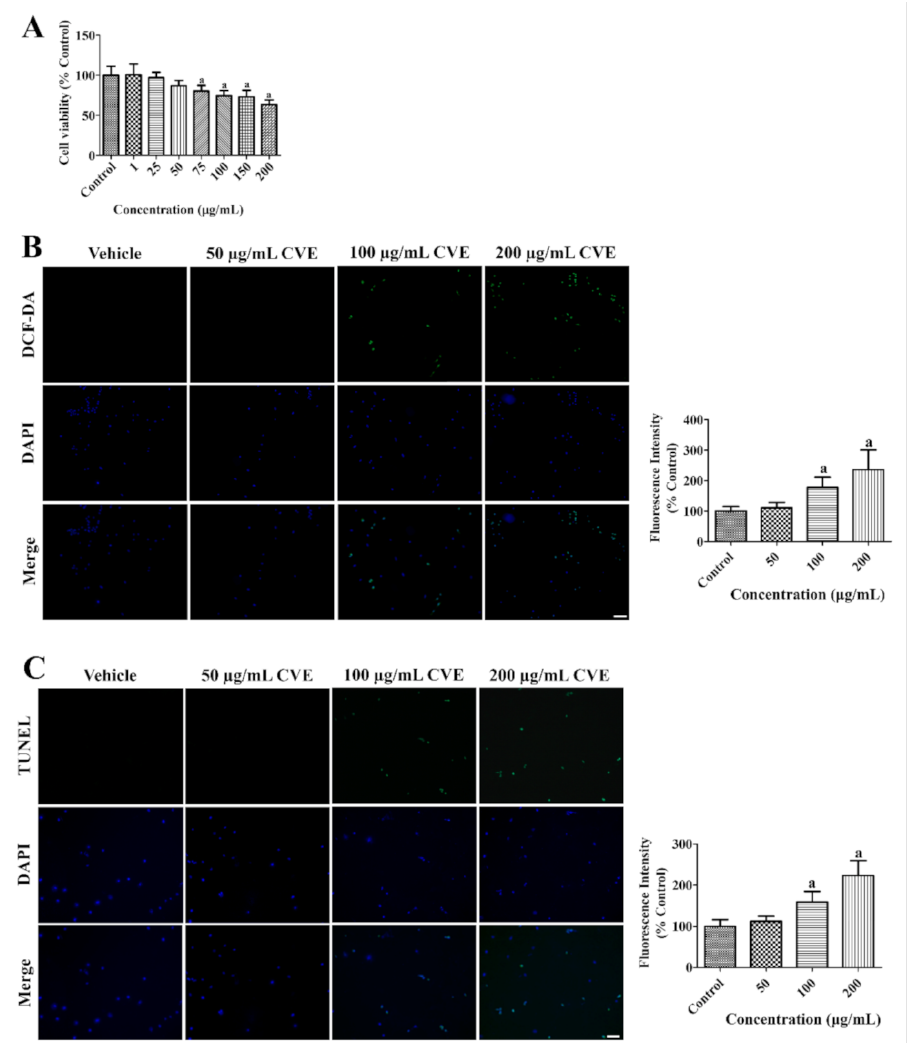
Figure 1. Cissus verticillata extract (CVE) has toxic effects in high concentration in HT22 cells. ( A ) Cellular toxicity of CVE was confirmed by WST-1 assay to determine the optimal concentration with minimal toxicity. ( B ) ROS formation and ( C ) DNA fragmentation was confirmed by DCF fluorescence and TUNEL staining, respectively, in the control, 50, 100, and 200 µ g/mL CVE-treated group for 60 min. Scale bar = 50 µ m. Fluorescent intensities are measured using an enzyme-linked immunosorbent assay (ELISA) reader. Data are presented as mean value ± standard deviation and were analyzed using one-way analysis of variance (ANOVA) followed by Bonferroni’s post hoc test ( a p < 0.05, significantly different from the control